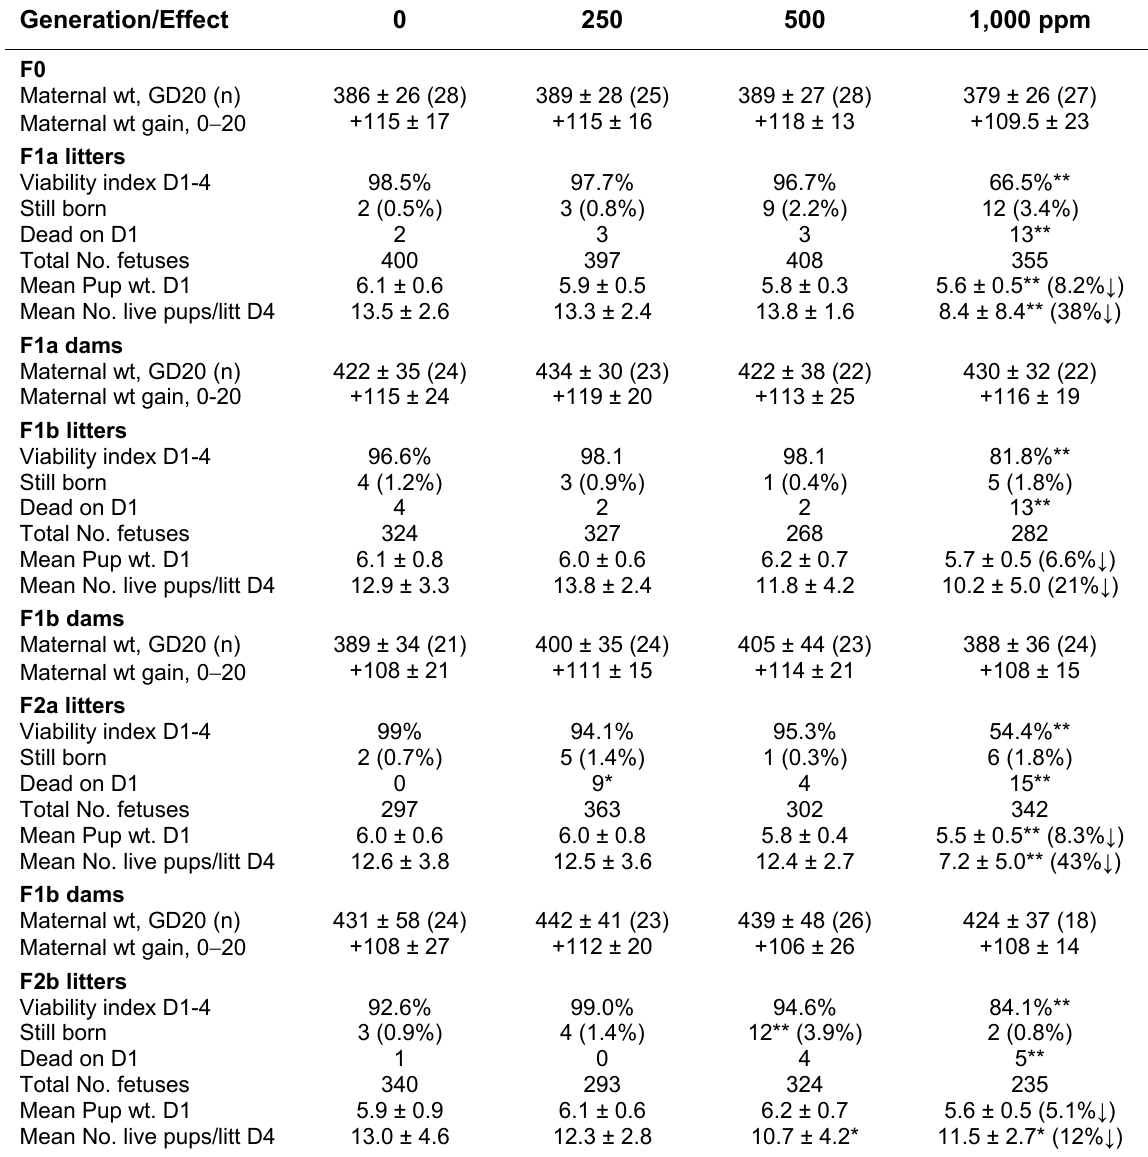
Reproductive Toxicity of Resmethrin in the Rat in a Two-Generation Study